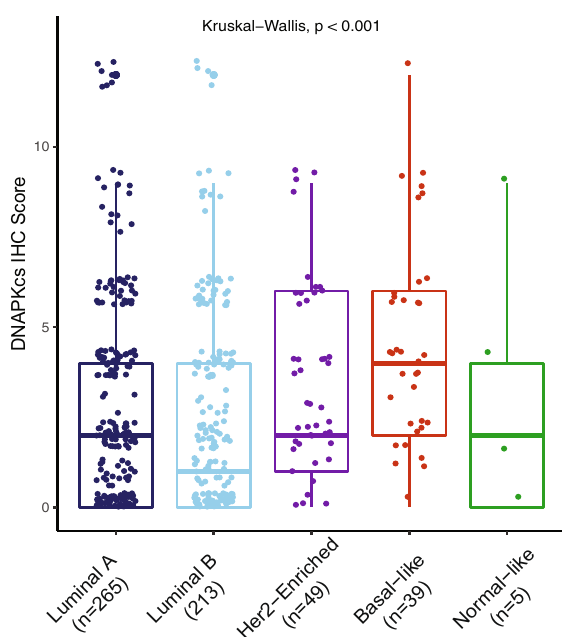
Fig. 5 Association of DNA-PKcs expression with PAM50 intrinsic subtype in a subset of the BC Cancer series. Boxplots showing the expression levels of DNA-PKcs by IHC across the different PAM50 gene expression intrinsic subtypes. High expression of DNA-PKcs is associated with basal-like PAM50 subtype ( p -value < 0.001). The median (center bar), and the third and fi rst quartiles (upper and lower edges, respectively) are